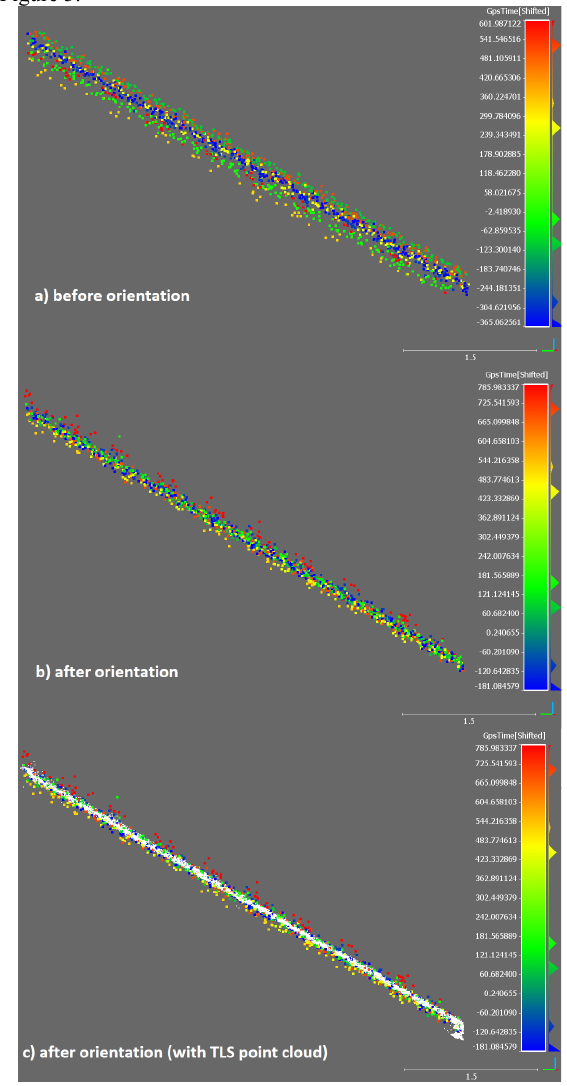
Fig. 3. Visualisation ULS point cloud (coded with GPS time to show strips) before (a) and after (b) with reference TLS